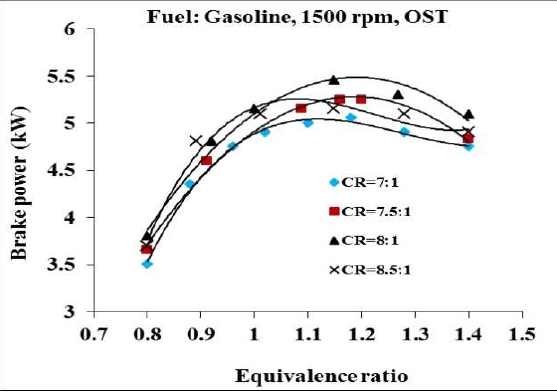
Fig. 2. Compression ratio effect on brake power for wide range of equivalence ratios of gasoline fuel.